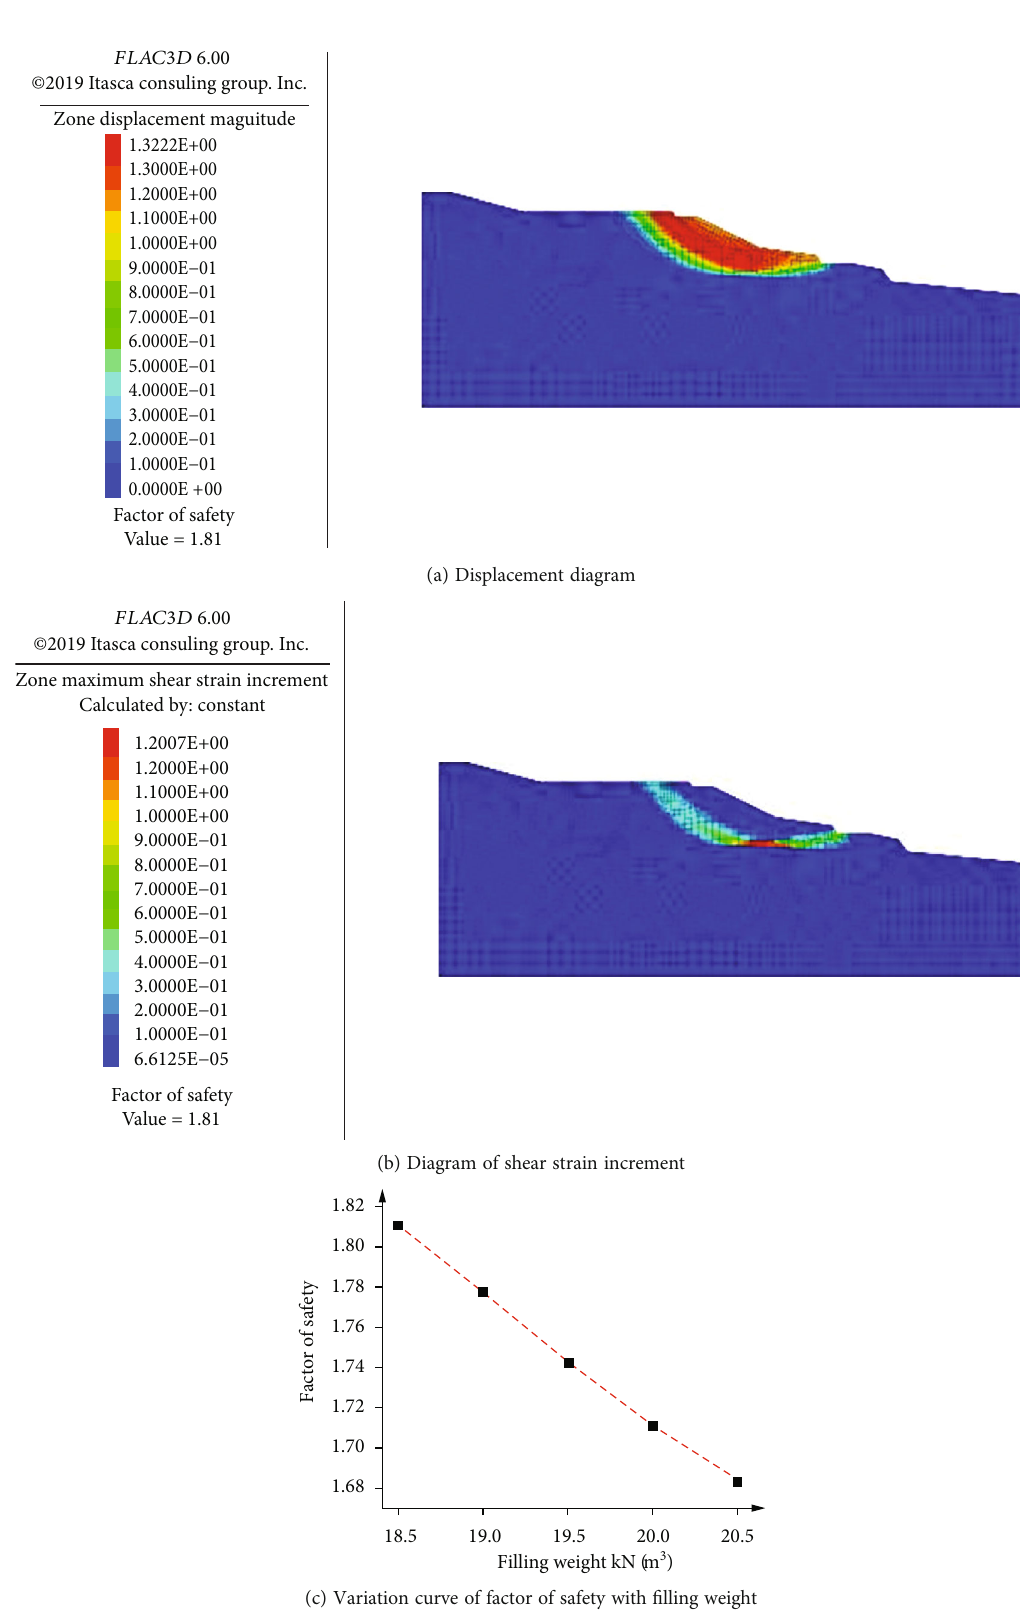
Figure 19: E ff ect of fi lling weight on slope